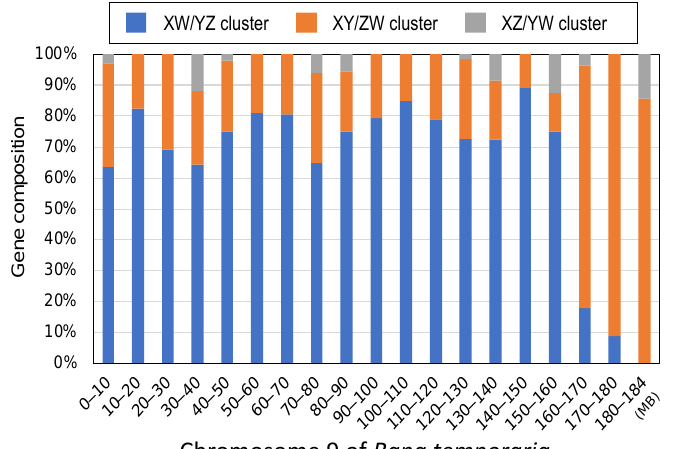
Figure 2. Composition of the sex-linked genes belonging to three different clusters along the chromo- somal axis. The genes of the XW/YZ, XY/ZW, and XZ/YW clusters are indicated in blue, orange, and gray, respectively.